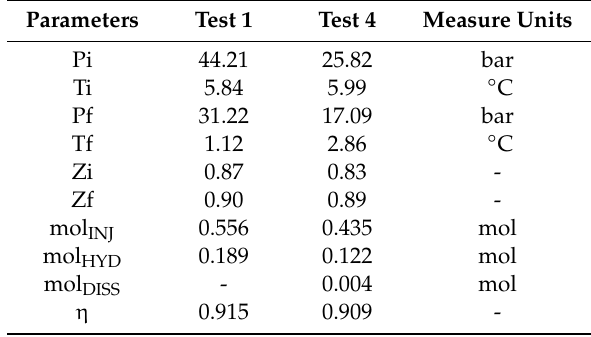
Table 1. Parameters related to Test 1 (with CH 4 ) and Test 4 (with CO 2 ).